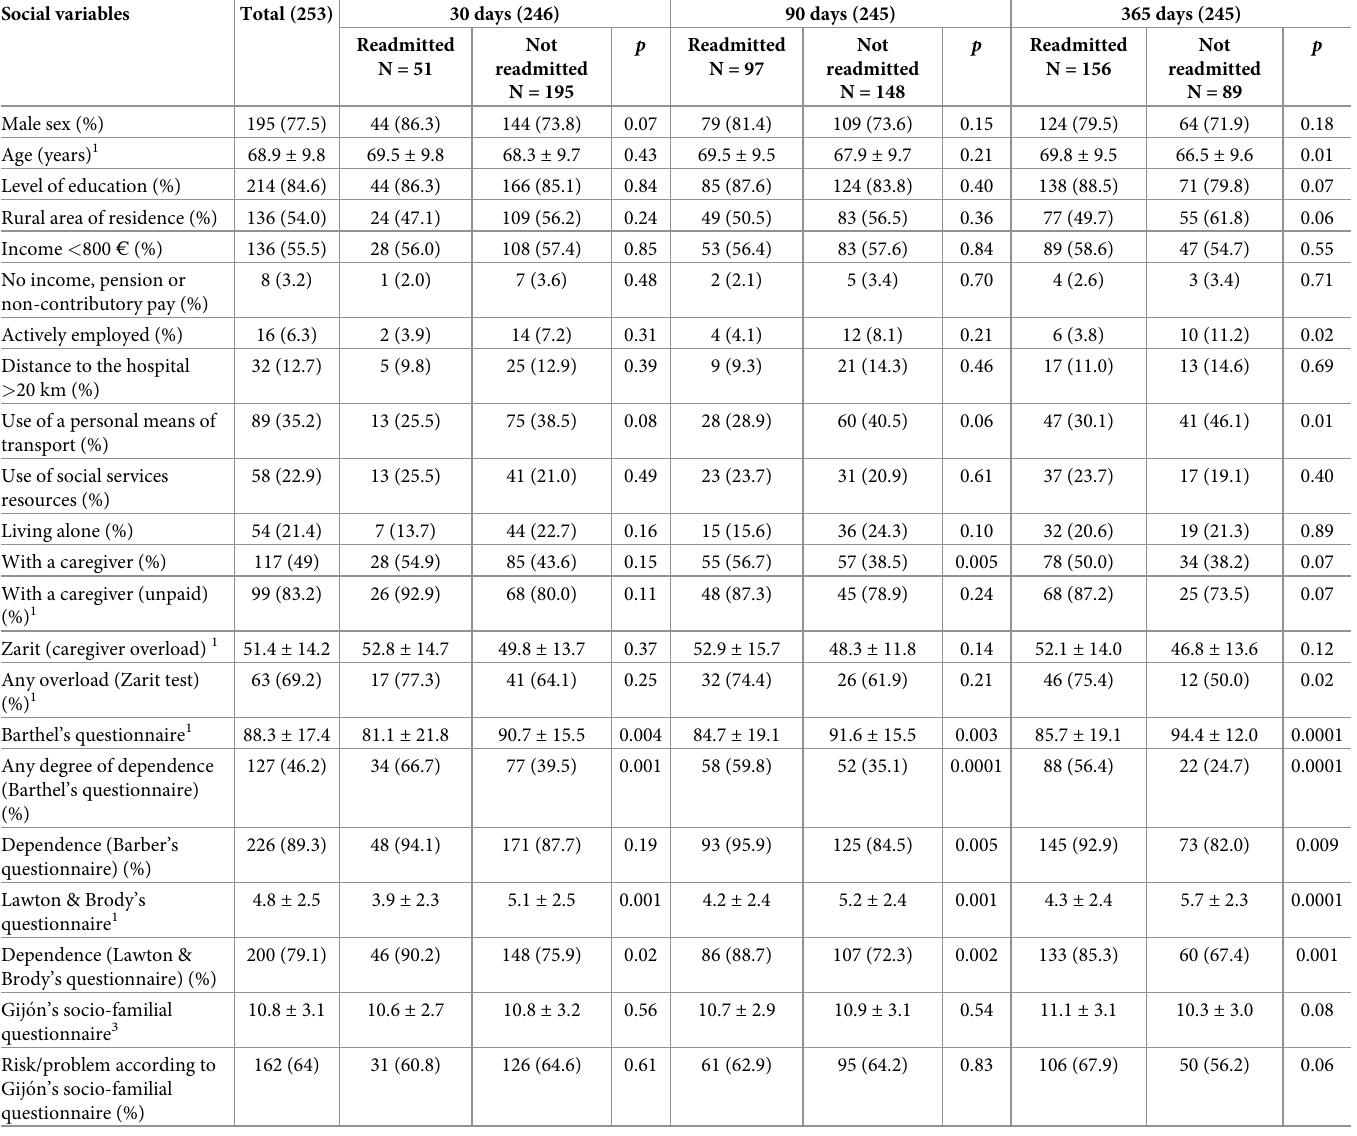
Table 1. Univariate analysis of the social and demographic variables predictive of readmissions at 30, 90, and 365 days. Social